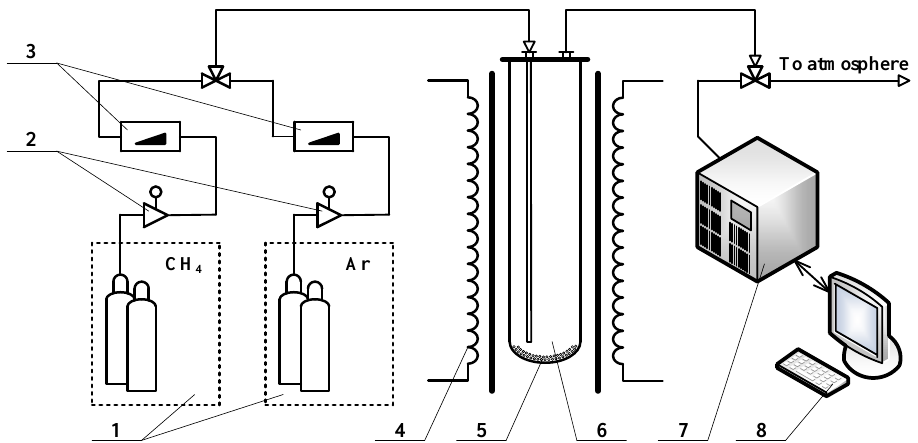
Figure 2. Scheme of catalytic setup for testing the decomposition of methane: 1 — gas vessel; 2 — reducing valve; 3 — mass flow controller; 4 — furnace; 5 — catalyst; 6 — vertical reactor; 7 — gas chromatograph; 8 — PC.